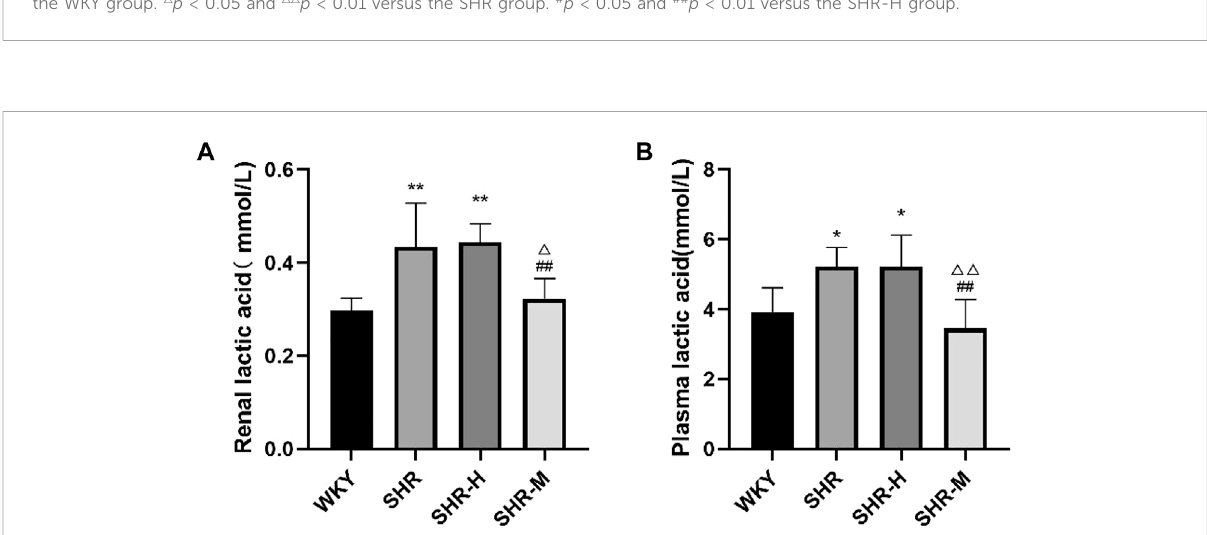
Effects of different intensity exercise training on renal function. NGAL, neutrophil gelatinase-associated lipocalin; BUN, blood urea nitrogen. Thehistograms re fl ectthecontentofthekidney injury indexandindicatethemeanvalues±SD( n =6ineach group).* p < 0.05 and** p < 0.01 versus the WKY group. △ p < 0.05 and △△ p < 0.01 versus the SHR group. # p < 0.05 and ## p < 0.01 versus the SHR-H group.